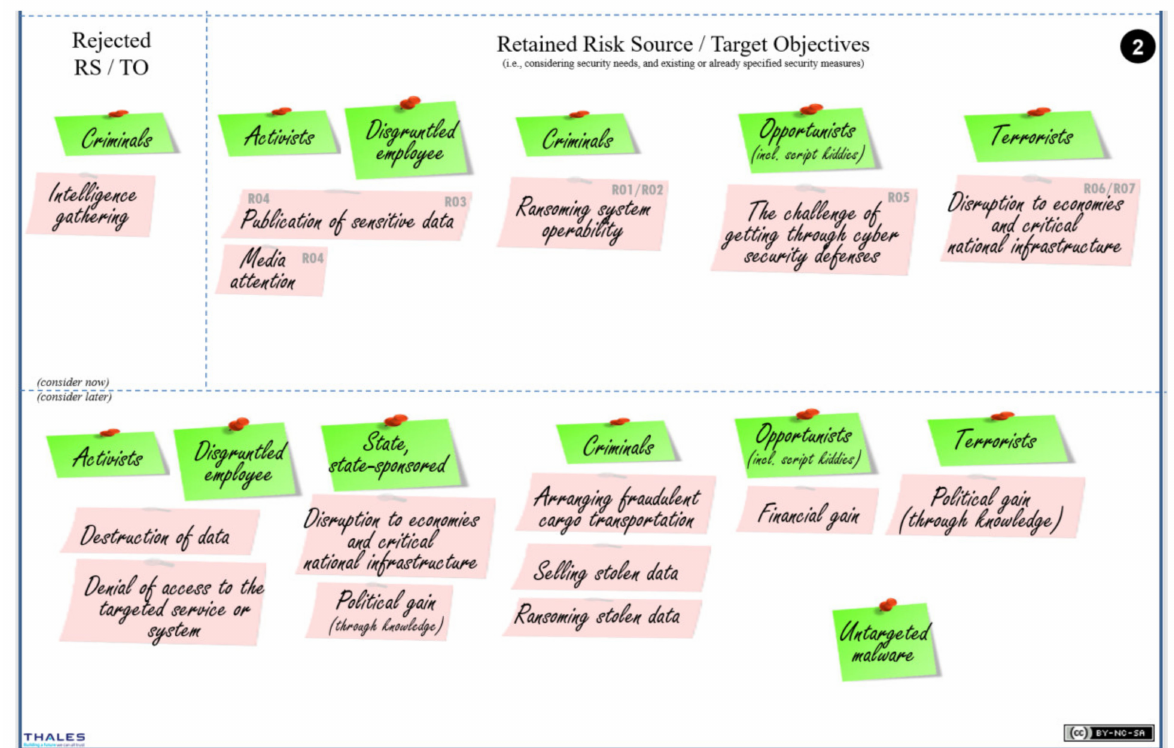
Figure 9. Ob é risk datasheet—workshop n ◦ 2: identification of adverse